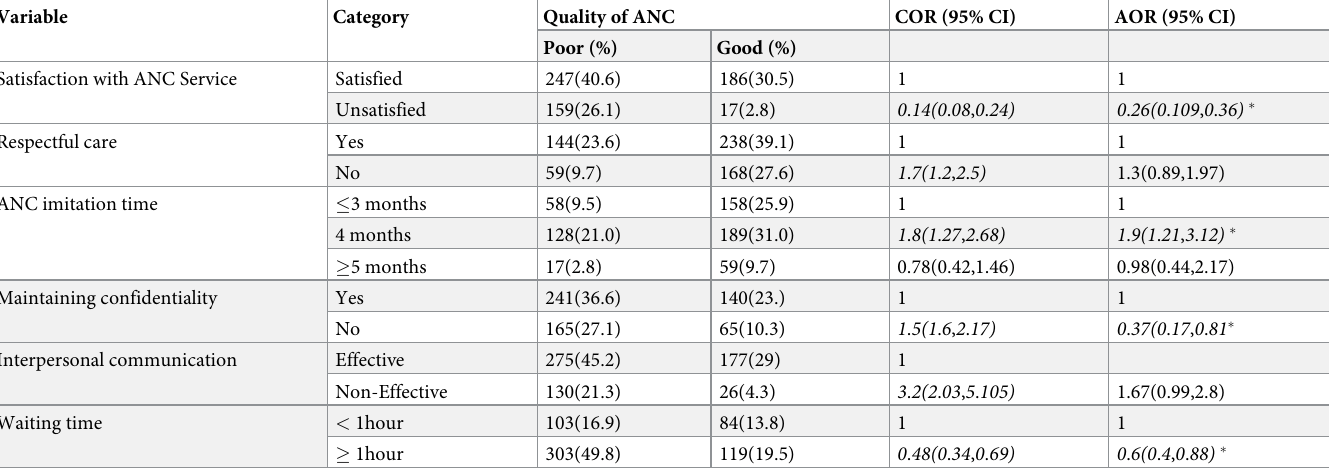
Table 3. Crude and adjusted odds ratios from logistic regression analysis of factors associated with quality of ANC service among pregnant women attending public health centers in Addis Ababa, February, 2020 (n =